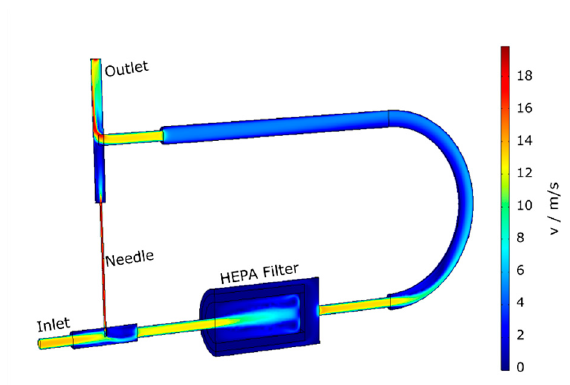
Figure 1. Velocities at the centered cut plane of the diluter at a total flow rate of (cid:1843) (cid:3047)(cid:3042)(cid:3047) (cid:3404) 2.1 (cid:3039) simulation performed using